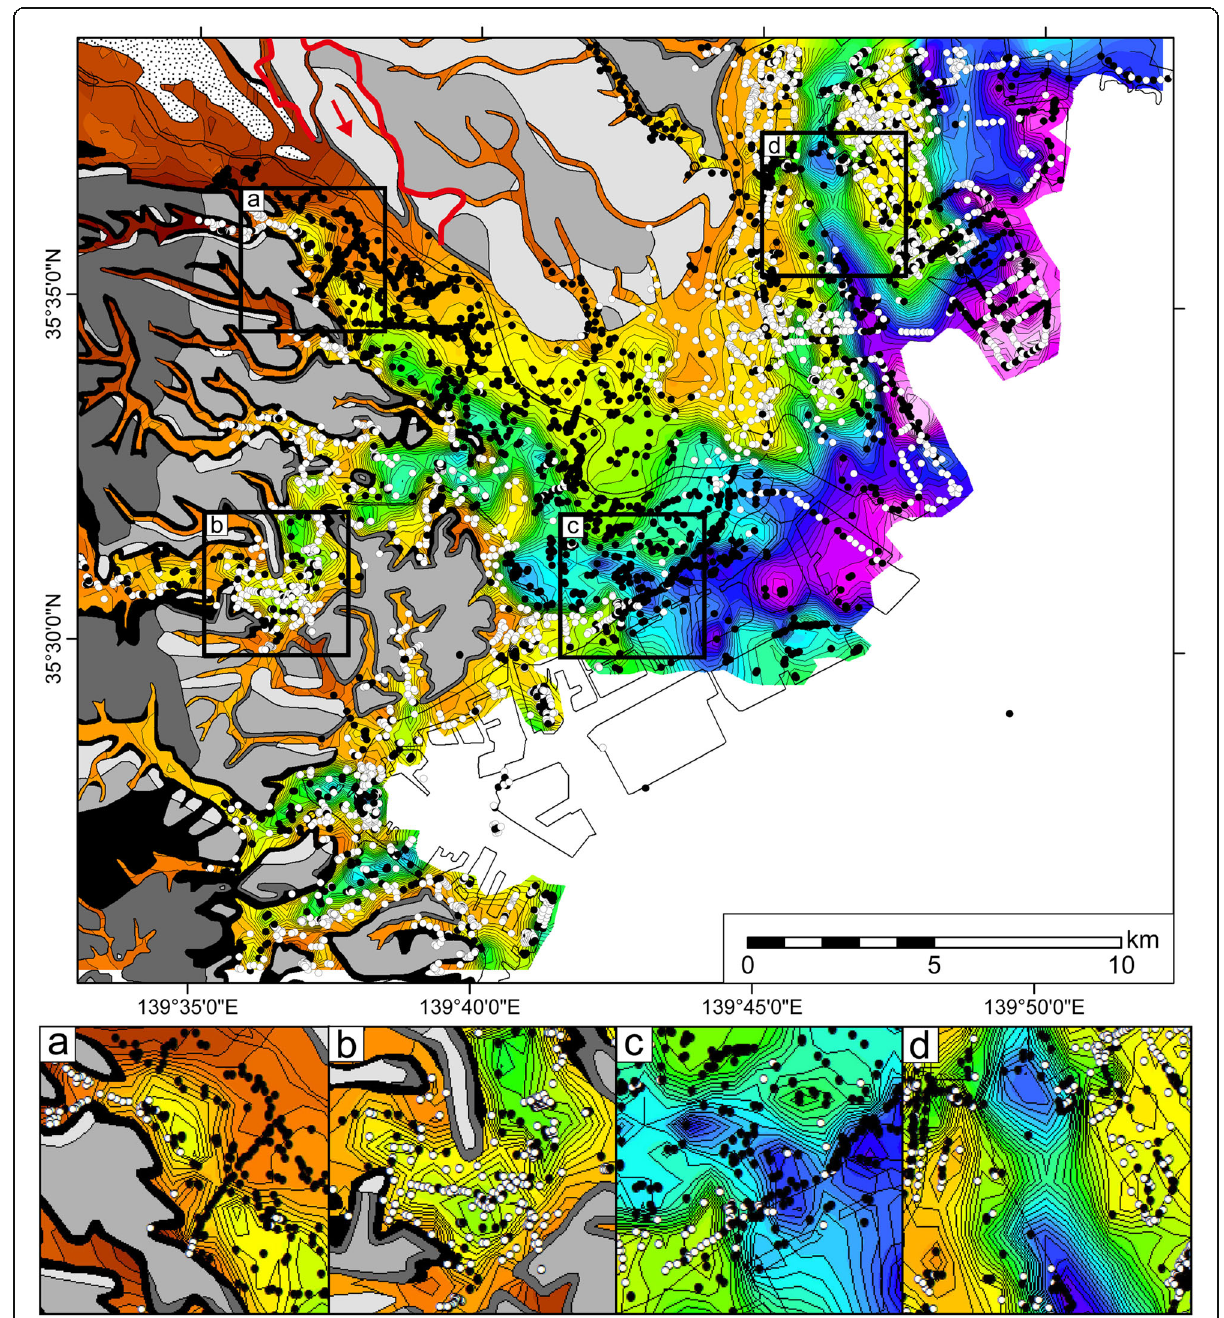
Fig. 9 Occurrences of gravel beds at the bases of the post-LGM incised-valley fills. Black and white dots indicate presence and absence of a gravel bed, respectively, and are plotted on the elevation map of Fig. 7. Gravel beds are frequent along the Tama River. a – d Show ×2 enlargements of the undulating topography at the bases of the LGM incised valleys. Borehole logs are available for the bottoms and margins of pits in ( a ), ( b ), and ( c ), but are not available for the pits in ( d